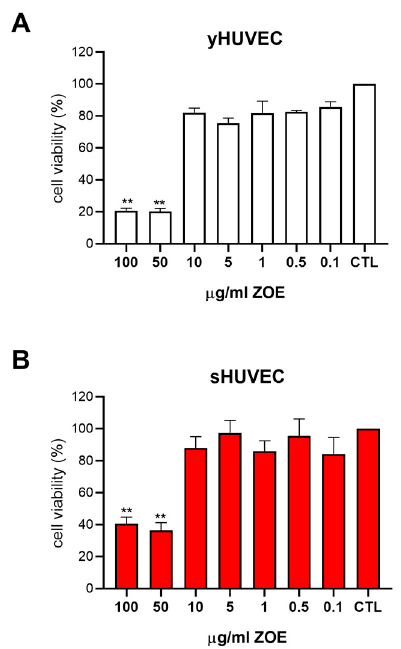
Figure 3. Dose–response curve of HUVEC to Zingiber officinale extract (ZOE). yHUVEC ( A ) and sHUVEC ( B ) were treated with different concentrations of ZOE (from 0.1 µg/mL to 100 µg/mL). Histograms indicate the percentage of cell viability normalized to the viability of DMSO-treated cells (CTL) and presented as mean value ± SD from three independent biological replicates. **, p < 0.01.